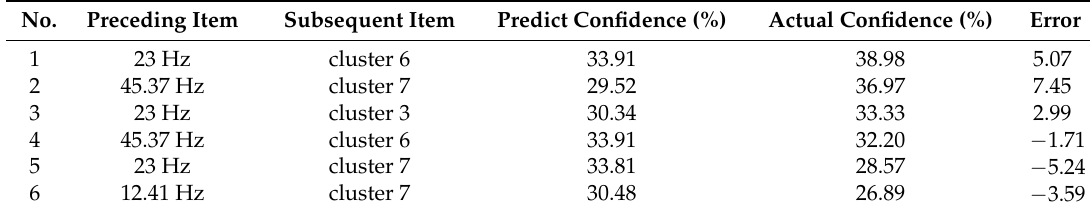
Figure 11 is a line graph comparing the confidence level of predicted results and practical results.